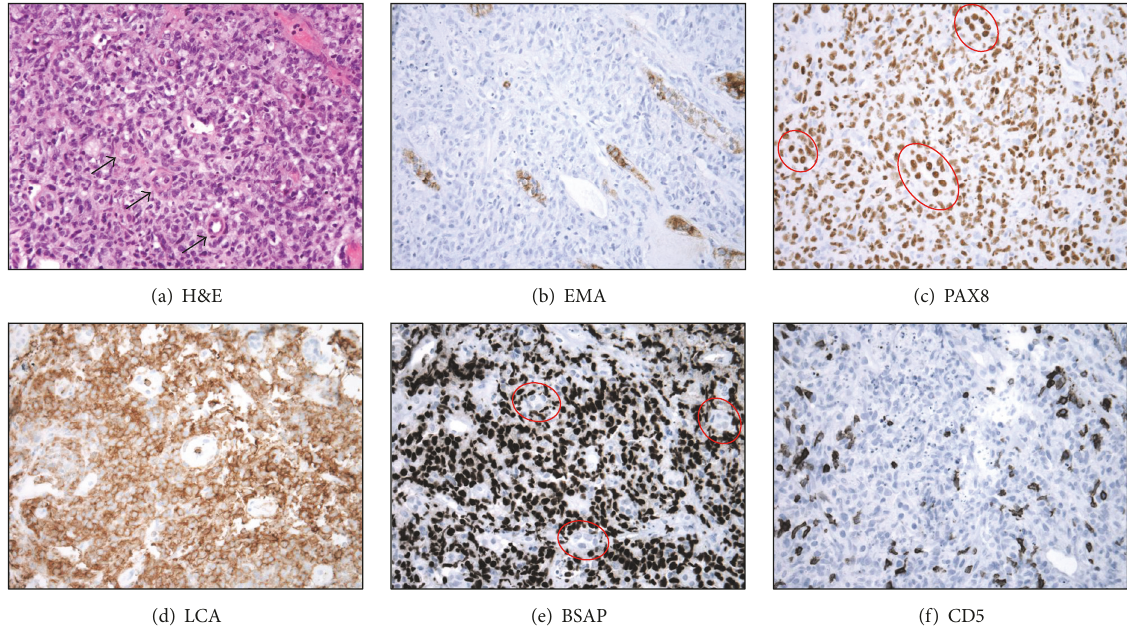
Figure 2: Morphologic and immunohistochemical features of the renal neoplasm support a diagnosis of diffuse large B-cell lymphoma. (a) H&E staining demonstrates an epithelioid neoplasm with a distinctive infiltrative pattern between renal tubules (nonneoplastic renal tubules highlighted by arrows). (b) An EMA immunostain is immunoreactive in the nonneoplastic renal tubules, but negative in the neoplasm. (c) A PAX8 immunostain is diffusely and strongly positive in both nonneoplastic renal tubules (red ovals) and the infiltrative neoplasm. (d–f) Subsequent LCA, PAX5/BSAP, and CD5 immunostains support the diagnosis of diffuse large B-cell lymphoma. Note the absence of PAX5 in nonneoplastic renal tubules (red ovals) and the presence of CD5 in nonneoplastic T-cell